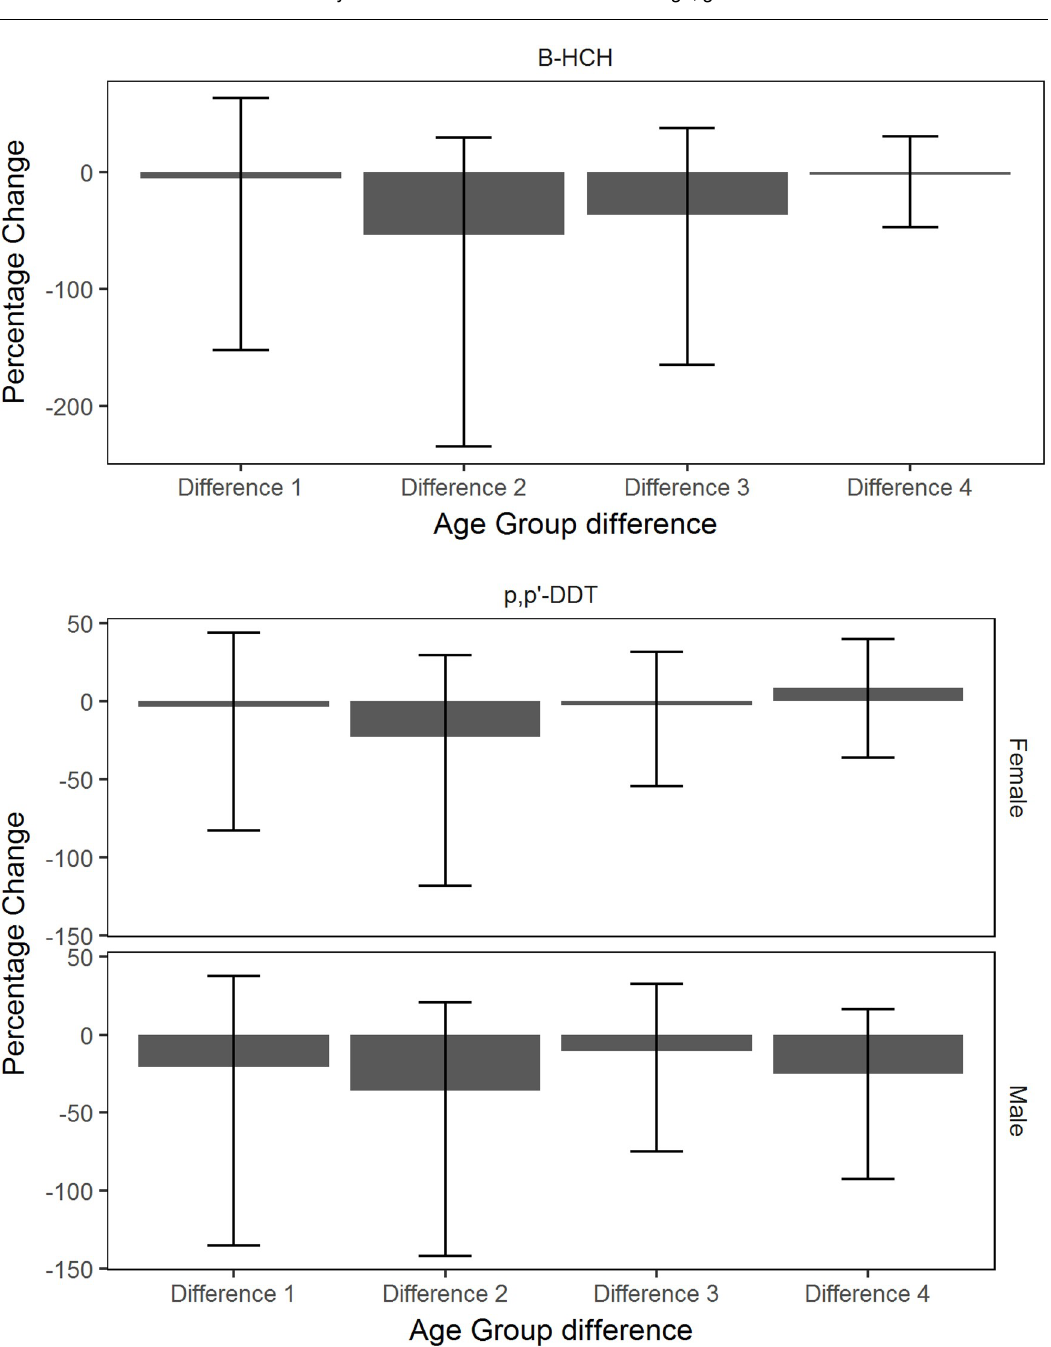
Fig 8. Percent change in OCP concentrations as sample population ages. The percent change (%) of β -HCH and p,p’ -DDT concentrations (ng/g lipid) between an age group sampled in 2002/03 and its adjacent older age group sampled in 2012/13. The error bars for each age group indicate the 95% credible interval of the percent change. L-R: Difference 1: 5-15 year olds in 2002/03 and 16- 30 year olds in 2012/13, Difference 2: 16-30 year olds in 2002/03 and 31-45 year olds in 2012/13, Difference 3: 31-45 year olds